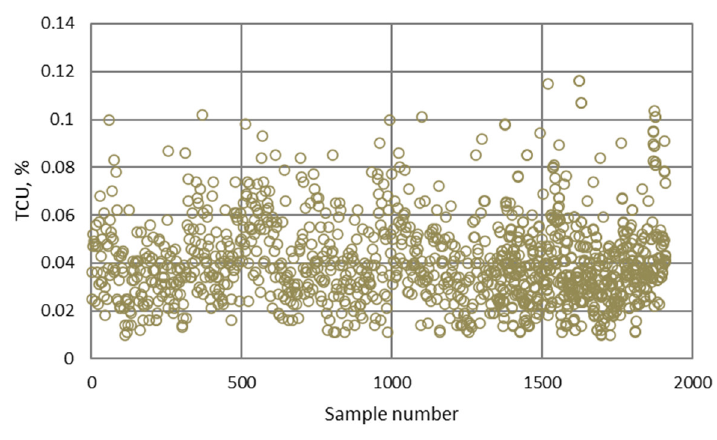
Figure A24. PMM model—testing dataset for TCU output variable.